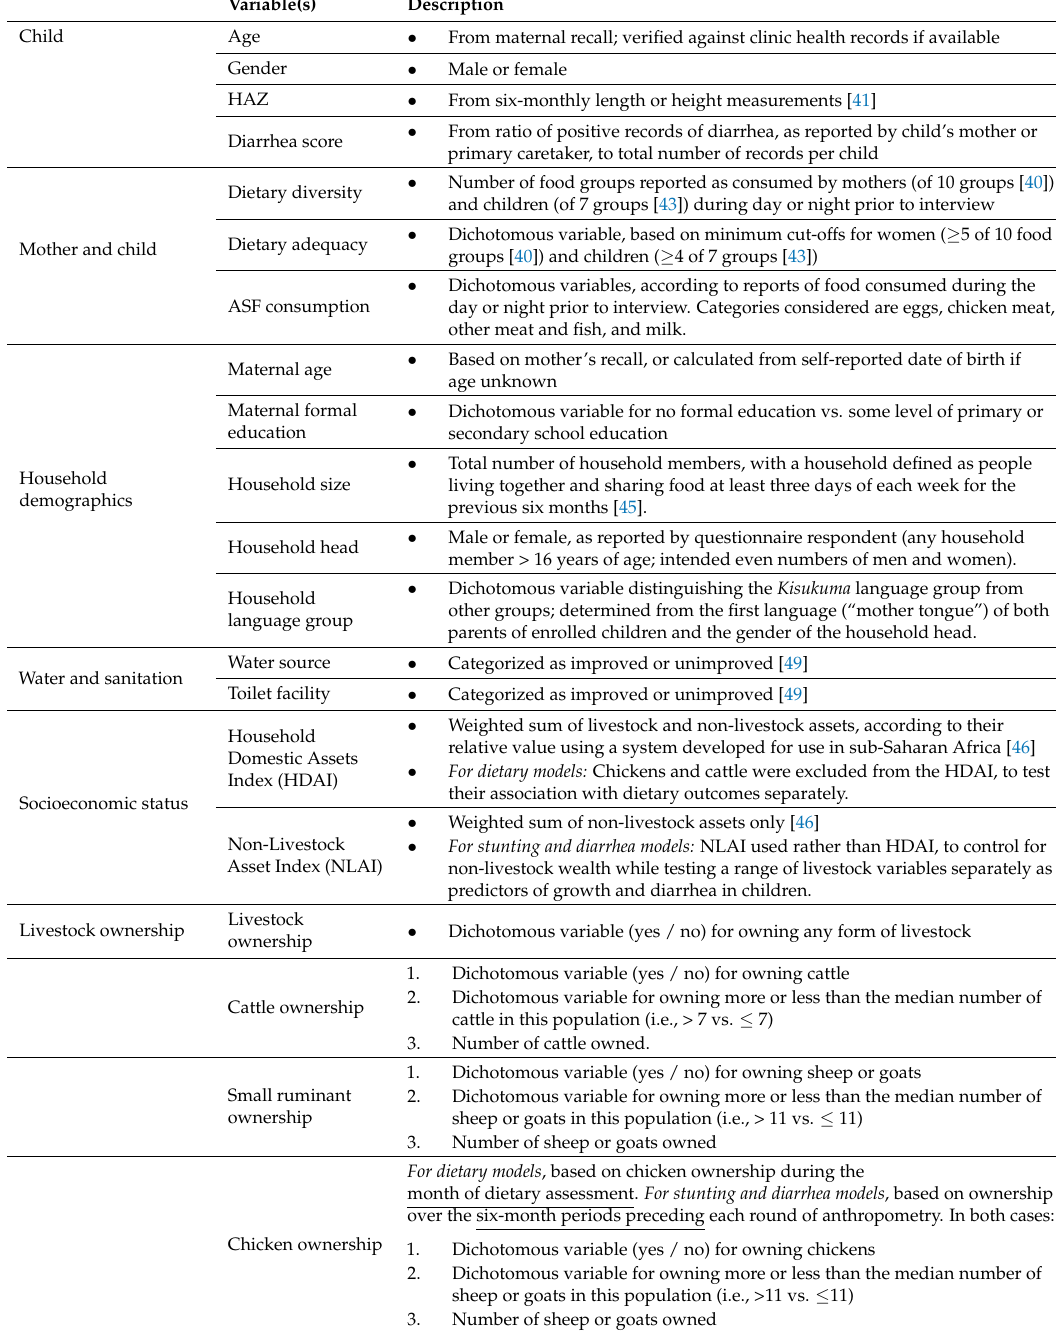
Table A1. Descriptions for predictor and outcome variables